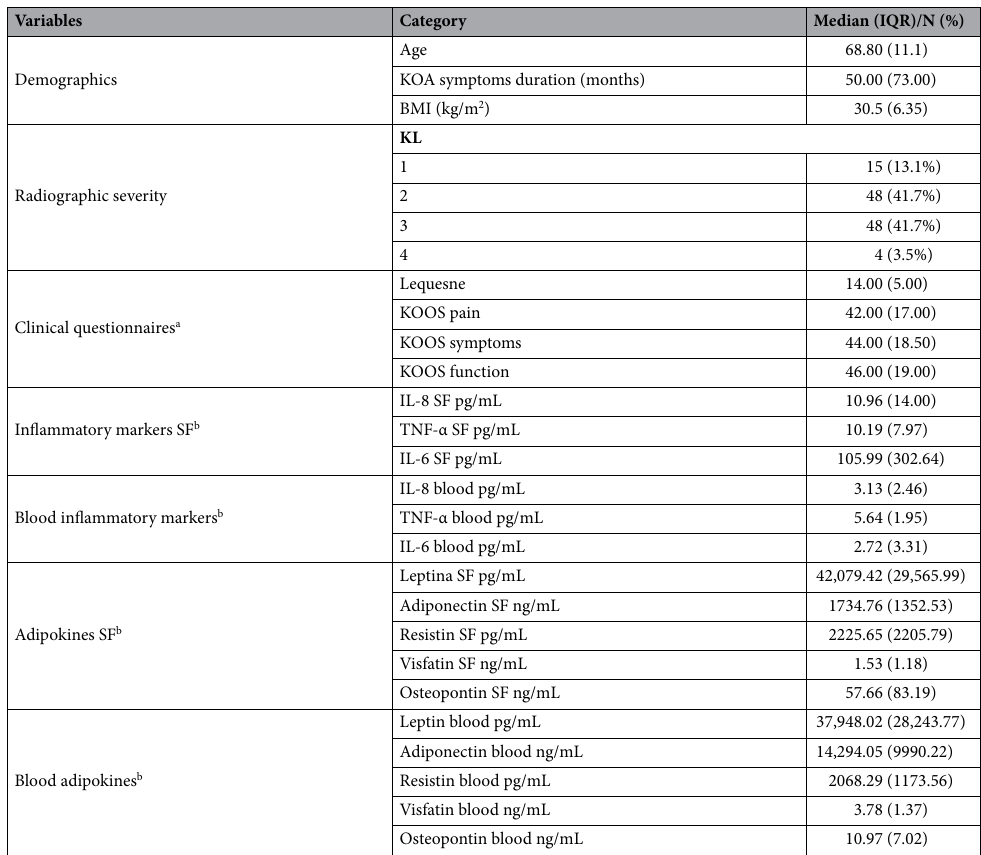
Table 1. Demographic variables, radiographic severity, clinical questionnaires, inflammatory markers and adipokines in synovial fluid and blood. Medians and interquartilic ranges (IQR) were used to describe continuous variables; categorical data were summarized using absolute frequencies (N) and percentages (%); KOA knee osteoarthritis, KL Kellgren–Lawrence scale, BMI Body Mass Index, KOOS Knee injury and Osteoarthritis Outcome Score, SF synovial fluid, IL-8 interleukin-8, IL-6 interleukin-6, TNF-α Tumor Necrosis Factor-alpha. a Clinical questionnaires range values and interpretation: Lequesne (range from 0 to 24; where 0 is non and 24 maximum degrees of pain or incapacity) KOOS pain, symptoms, and function (range from 0 to 100; where 0 is maximum and 100 minimum of each condition evaluated). b Levels of inflammatory markers and adipokines in synovial fluid and blood were corrected a-priori by measure